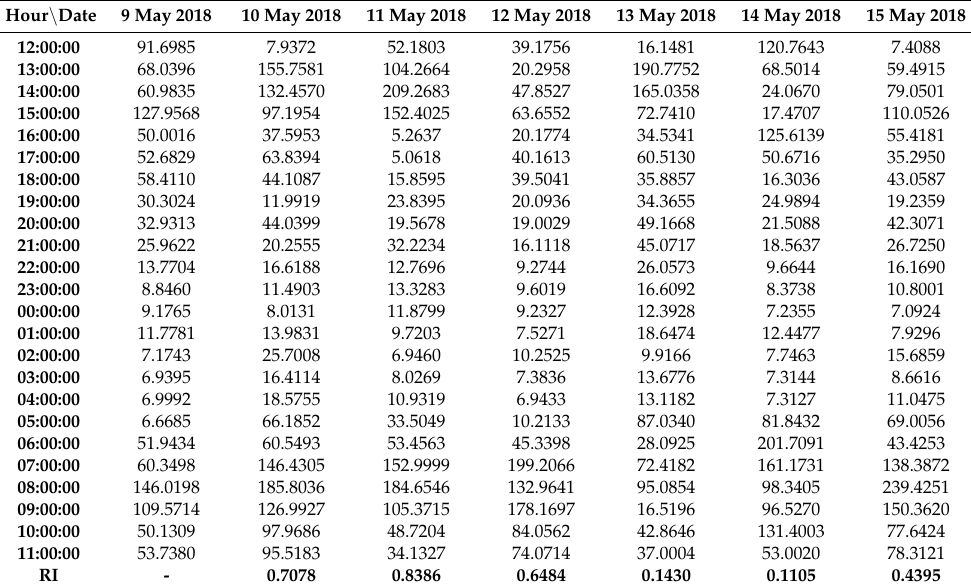
Table 2. A sample of one-week data, illustrating assessment of